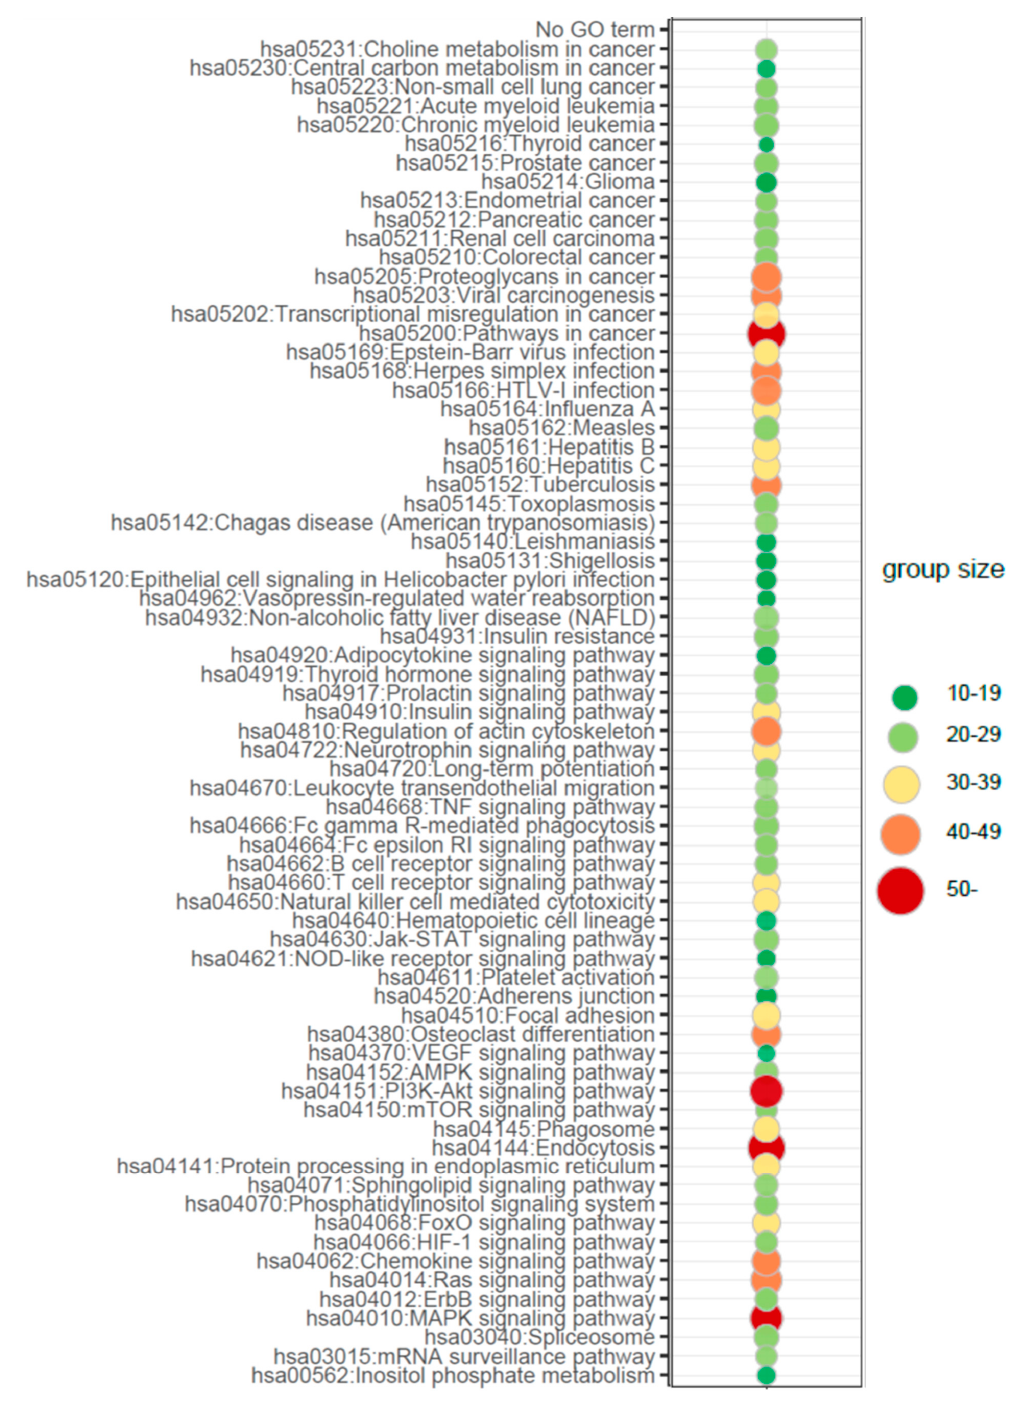
Figure 3. Bubble plot of overrepresented gene sets in DAVID Gene Ontology-Biological Process (GO BP) annotations database obtained from comparisons in miRNA transcript expression profiles between preterm vs. term newborns. The graph displays only the Gene Ontology (GO) groups above the established cut-o ff criteria ( p with correction < 0.05, a minimal number of genes per group > 10). The color of each bubble, according to the legend, reflects the number of di ff erentially expressed genes, assigned to the GO BP terms. Interestingly, analysis of biological processes regulated by di ff erentially expressed miRNAs target genes revealed processes of characteristic for the regulation of angiogenesis and activity of endothelial